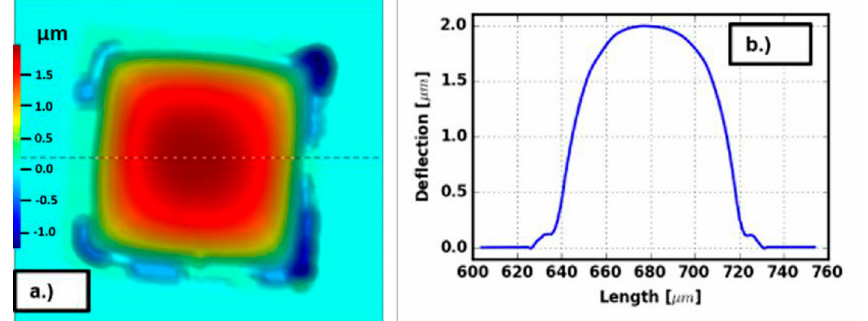
Figure 2. SEM micrographs of porous silicon carbide generated with MAPCE ( a ) After 150 min of etching. A highly porous layer with a line of breakage at the bottom ( b ) Porous SiC covered with 0.5 µm of amorphous